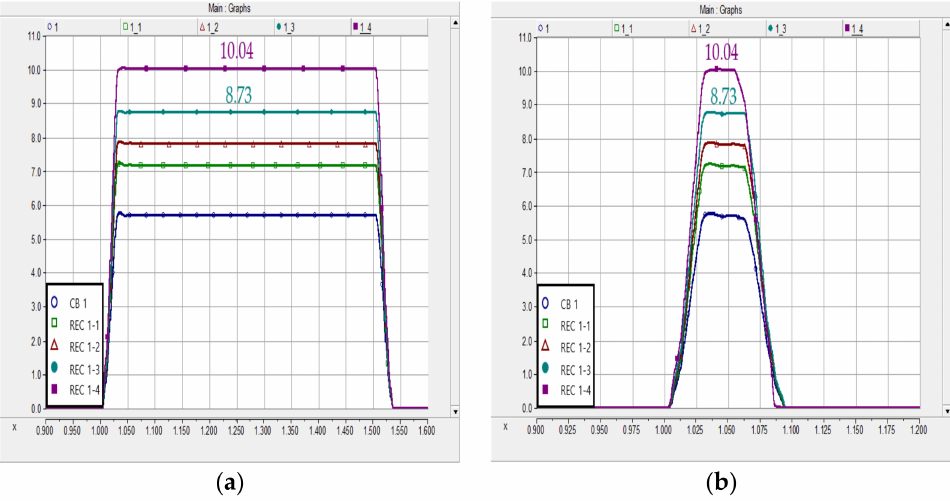
Figure 12. Phase-to-phase short circuit simulation: measured values for each breaker of feeder 1. ( a ) Before applying algorithm; ( b ) after applying